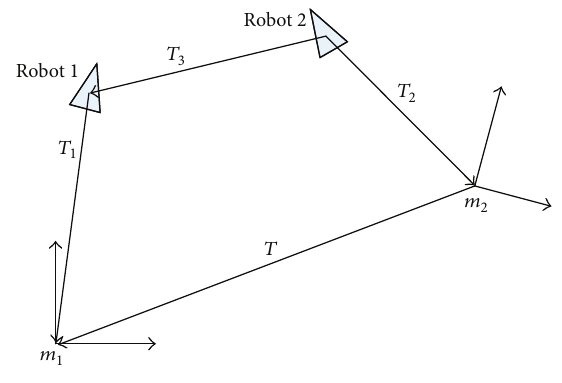
Figure 5: Relative pose of